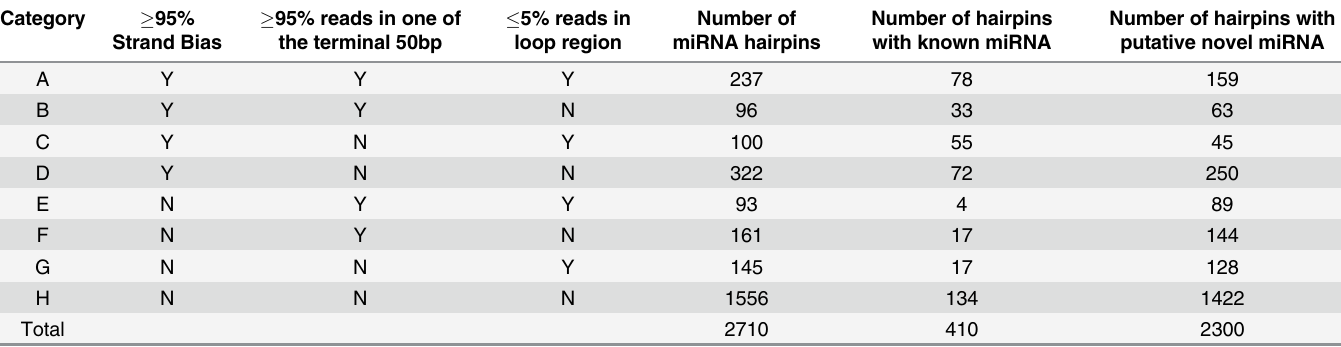
Table 2. Summary of putative miRNA hairpins in durum wheat small RNA libraries.